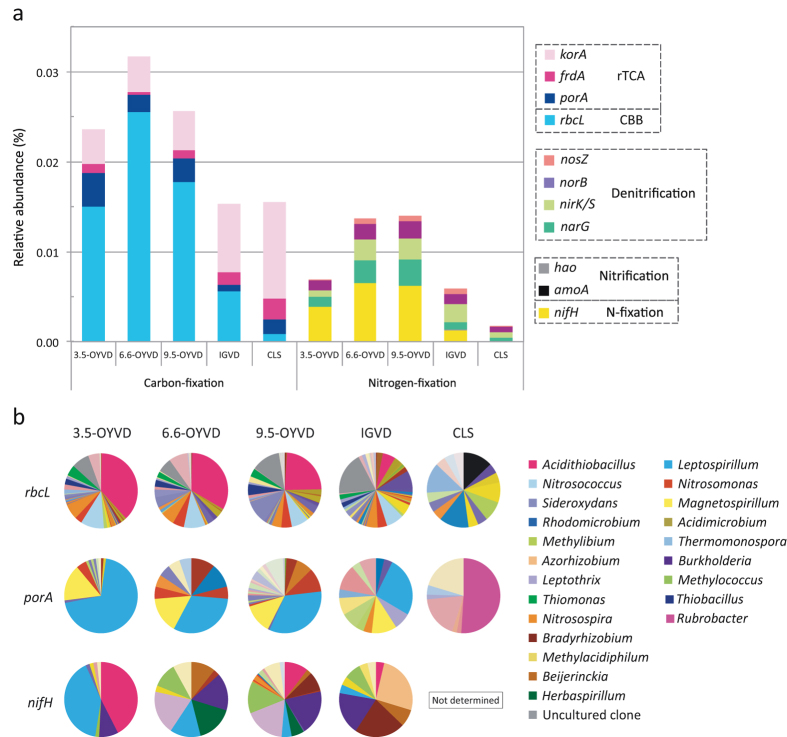
Relative abundances of carbon-fixation and nitrogen-cycling genes and taxonomic assignments of carbon and nitrogen fixers.(a) Relative abundances of targeted genes were calculated as the ratio of predicted ORFs in each sample to the total number of ORFs (Supplementary Table S3). Colour legends are shown. (b) Relative abundances of the taxonomic assignments of the rbcL, porA and nifH genes were calculated as the ratio of each assigned gene sequence to the total number of sequences. Colour legends of major genera are shown in this figure; those of minor genera are shown as original data in Supplementary Table S5.